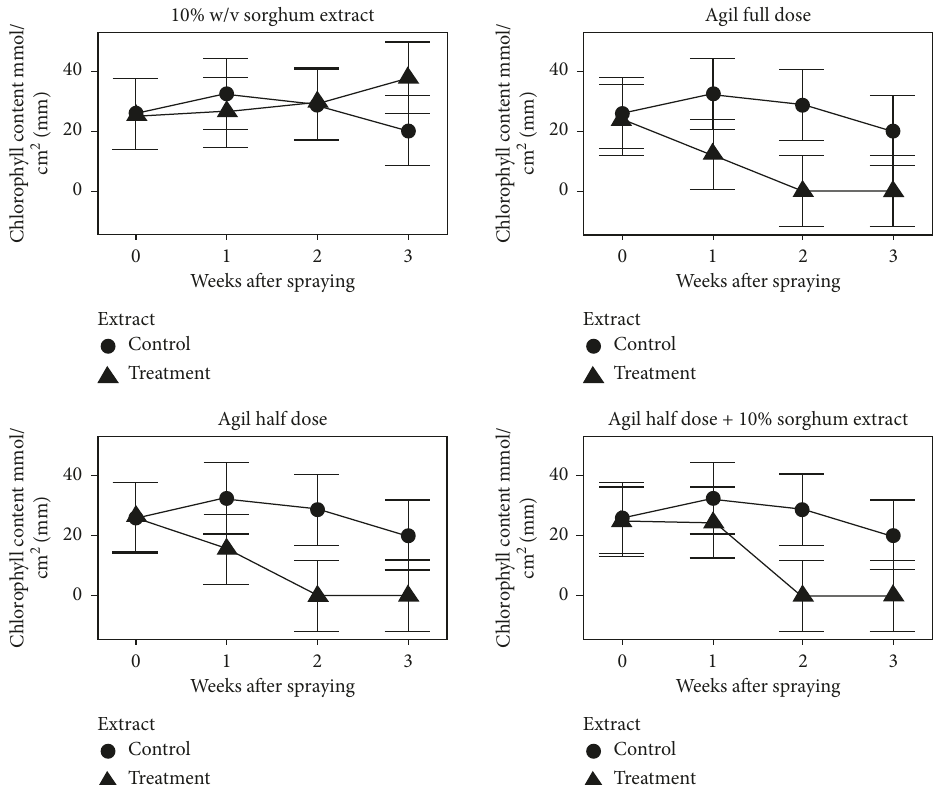
Figure 1: Effect of postemergence treatments on thechlorophyll content of goose grass. Error bars indicate least significant differences (LSD 5%). Table 8: Effect of different concentrations of sorghum leaf and stem aqueous extracts on PAL, POD, and PPO activity in the sesame variety Lindi